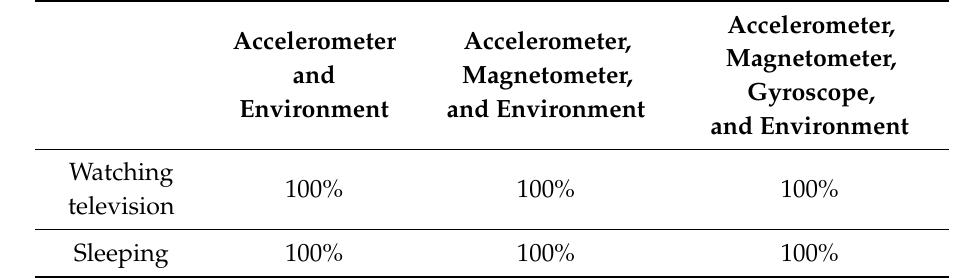
Table 13. Accuracies of the activities’ recognition without motion using the AdaBoost with the decision stump method implemented with Weka software for motion and magnetic sensors after the recognition of the environment.